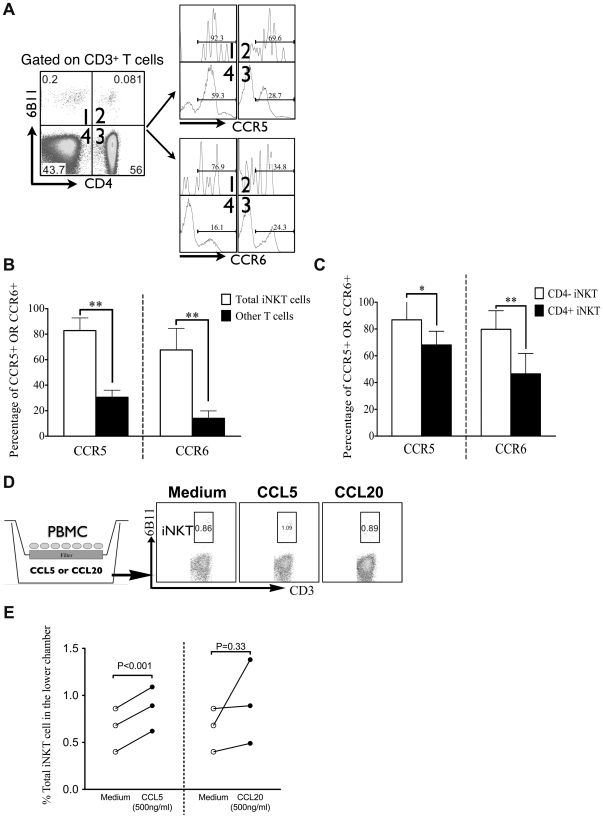
Peripheral iNKT cells expressed high levels of CC chemokine receptor 5 (CCR5) and CCR6.(A) Representative dot plots of CD3+6B11+ iNKT and CD3+6B11- T (Other T) cells from CHB patients (n = 6) and histograms of CCR5 and CCR6 expression within each quadrant. (B, C) Pooled data compared the expression of CCR5 and CCR6 between iNKT and other T cells, between CD4− and CD4+ iNKT cells from CHB patients. *P<0.05, **P<0.01, using Mann-Whitney U test. (D) Schematic diagram of migration assay. Fresh isolated PBMC were added into the upper chamber, 500 ng/ml CC chemokine ligand 5 (CCL5), CCL20 or medium alone was added into the lower chamber. Ten hours later, the cells of the lower chamber were harvested and analyzed. (E) Pooled data compared the percentages of iNKT cells in the lower chamber using paired t-test.